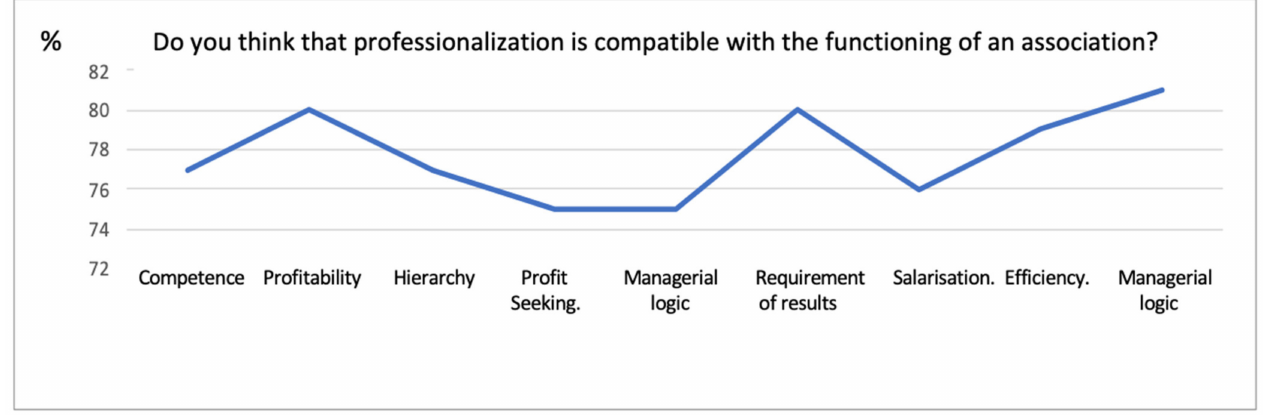
Figure 1. The level of compatibility of non-profits functioning with